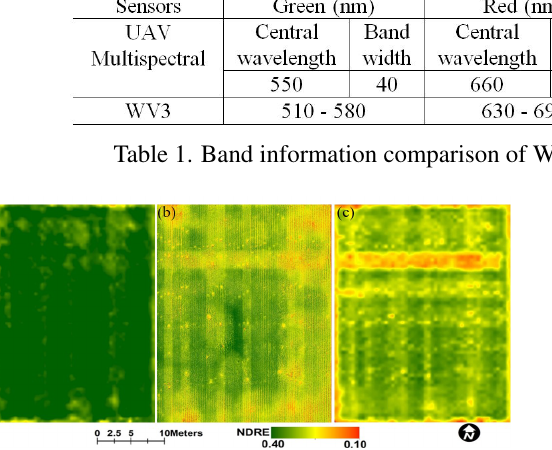
Figure 4. Spatiotemporal change of NDRE. Spatial